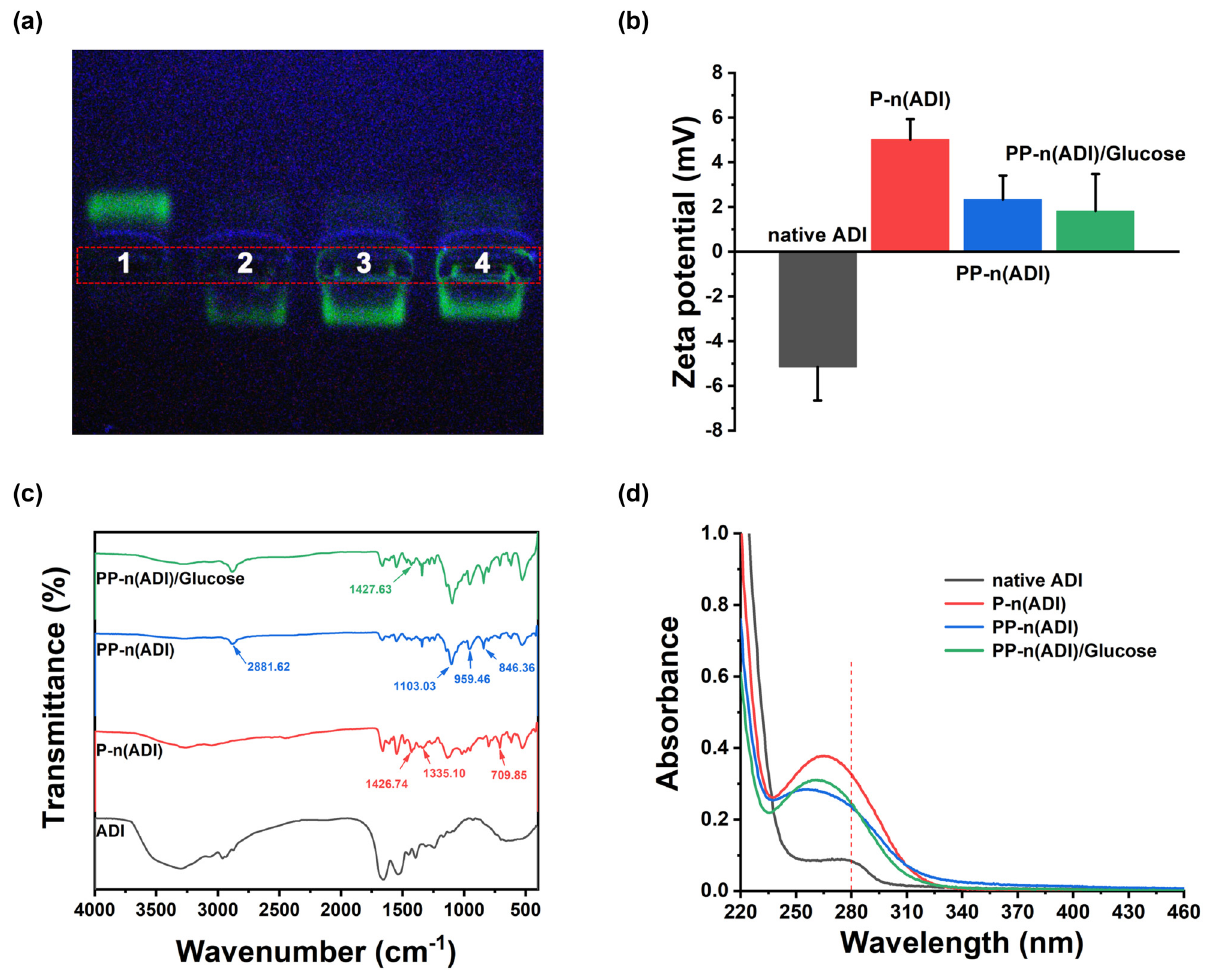
Figure 2: ( a ) Native ADI ( 1 ) , P - n ( ADI ) ( 2 ) , PP - n ( ADI ) ( 3 ) , and PP - n ( ADI ) /Glucose ( 4 ) were analyzed by agarose gel electrophoresis. ( b ) Zeta potential of corresponding samples. ( c ) FT - IR spectra of corresponding samples. ( d ) The UV - visible spectrum of corresponding samples.